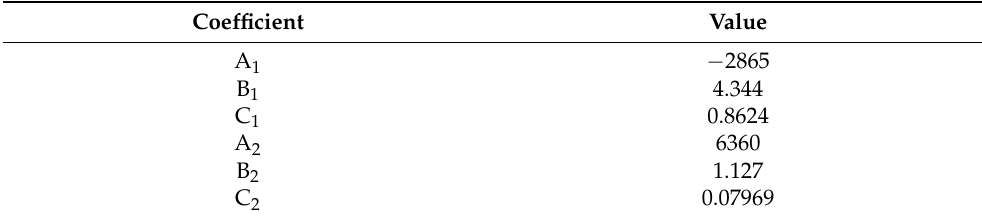
Table 2. Coefficients used in the Jurinak model (Equations (1)–(4)).